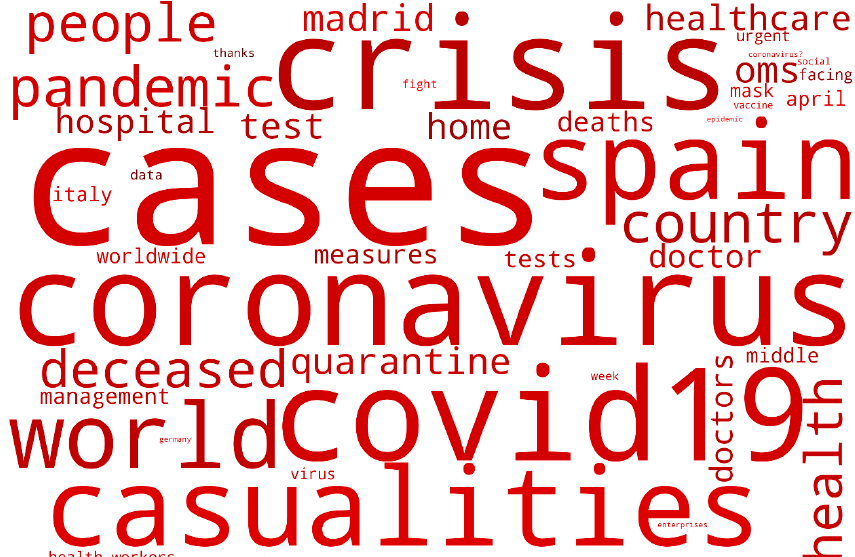
Figure 5. Word cloud generated during the period 1 March 2020 until 30 April 2020 related to terms about COVID-19.